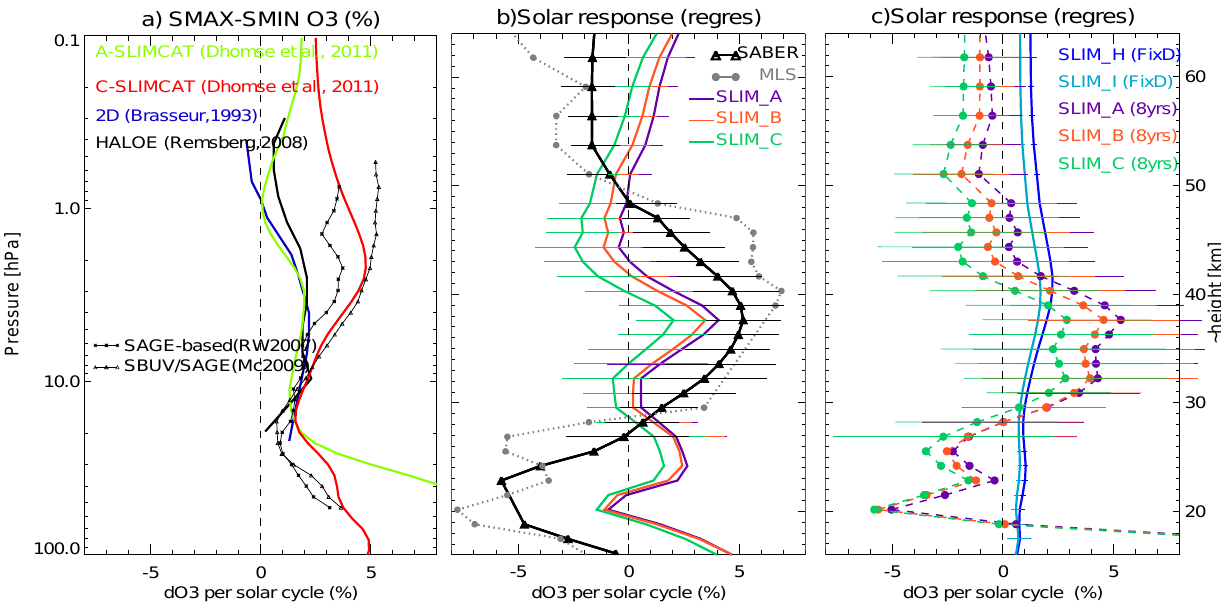
Fig. 7. (a) Tropical solar signal (25 ◦ S–25 ◦ N) per solar cycle from SLIMCAT simulations for 1979–2010 with ERA-40 and fixed dynamics (Dhomse et al., 2011, green and red lines), HALOE (1992–2005, Remsberg, 2008, black line) and a 2-D model (Brasseur, 1993, blue line). The estimated solar signals using SBUV/SAGE data (McLinden et al., 2009, triangles), SAGE-based data (Randel and Wu, 2007, stars) and a 3-D model (light-green line) by Dhomse et al. (2011) for 1979–2005 are also shown. (b) Estimated solar signal using multivariate regression model for modelled (2001–2010, 120 months), SABER (2002–2010, 108 months) and MLS (2004–2010, 77 months) O 3 data sets. Estimated errors (1 σ ) for solar coefficients are shown with coloured horizontal lines. The large error bars ( ± 10%) at all levels for MLS data and in the lower stratosphere for SABER and model data are not shown. (c) The coloured dashed lines with filled circles show the solar signal from runs A_NRL and B_SATIRE if only 8yr (2003–2010) of model data are used. The estimated solar signals from the runs (fixed dynamics) H_NRLF and I_SATIREF are shown with dark and light blue lines,